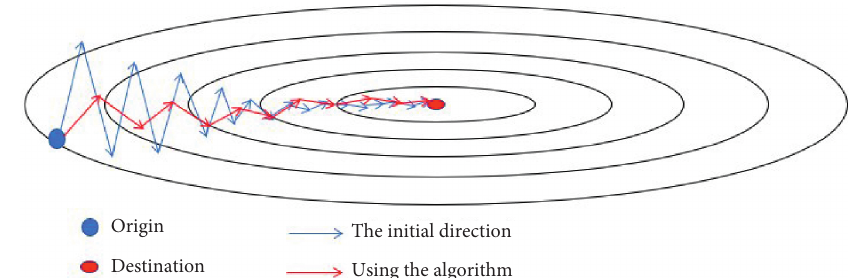
Figure 10: Optimization of neural network.